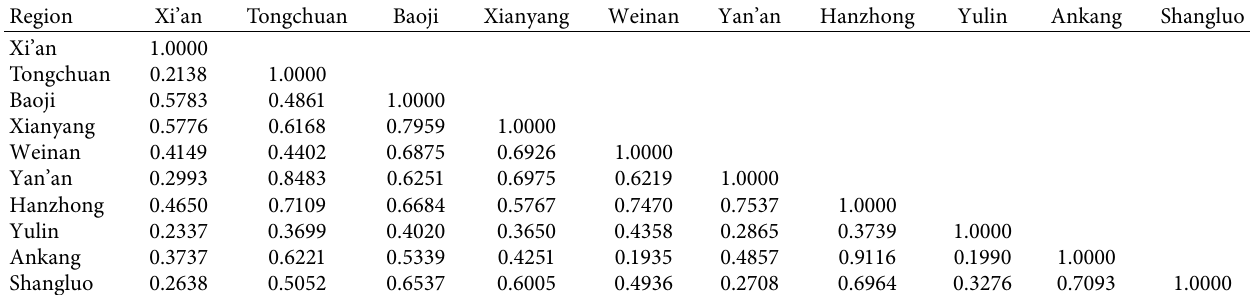
Table 3: Composite niche overlap matrix of prefectures in